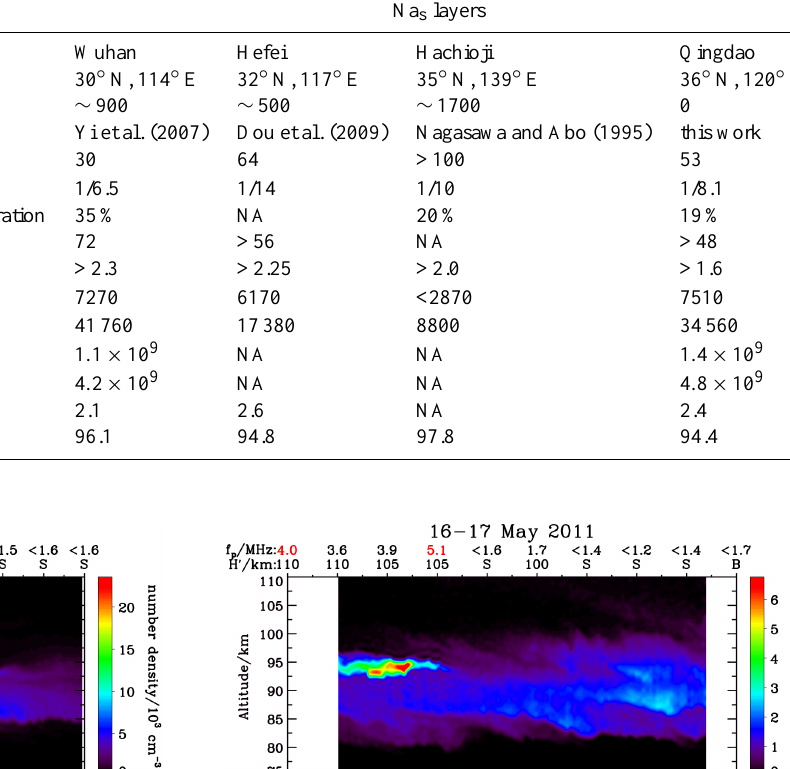
Table 2. Statistical characteristics of Na s layers observed at different lidar sites in the midlatitude region. Parameters